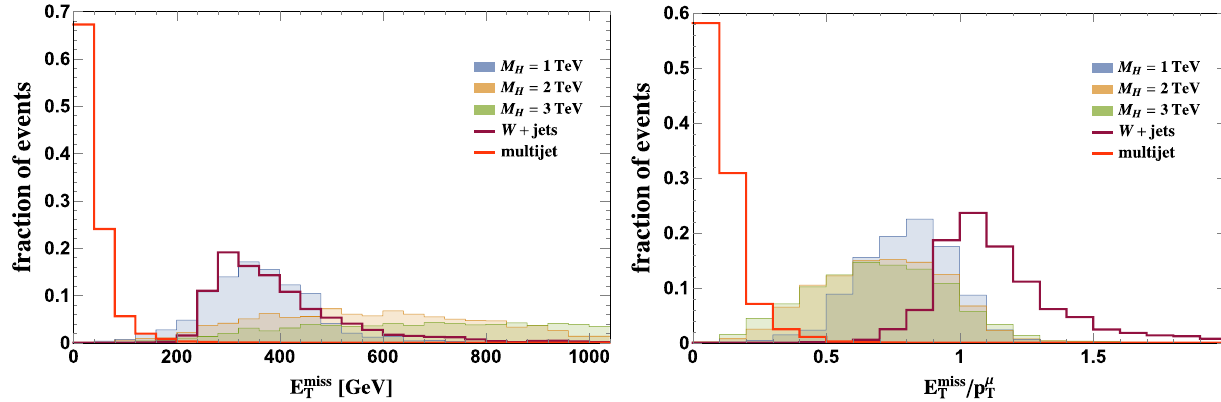
Fig. 2 Distribution of the missing transverse energy E miss / p μ E miss (right) for three signal benchmarks ( M H = 1 TeV, 2 TeV, and T T